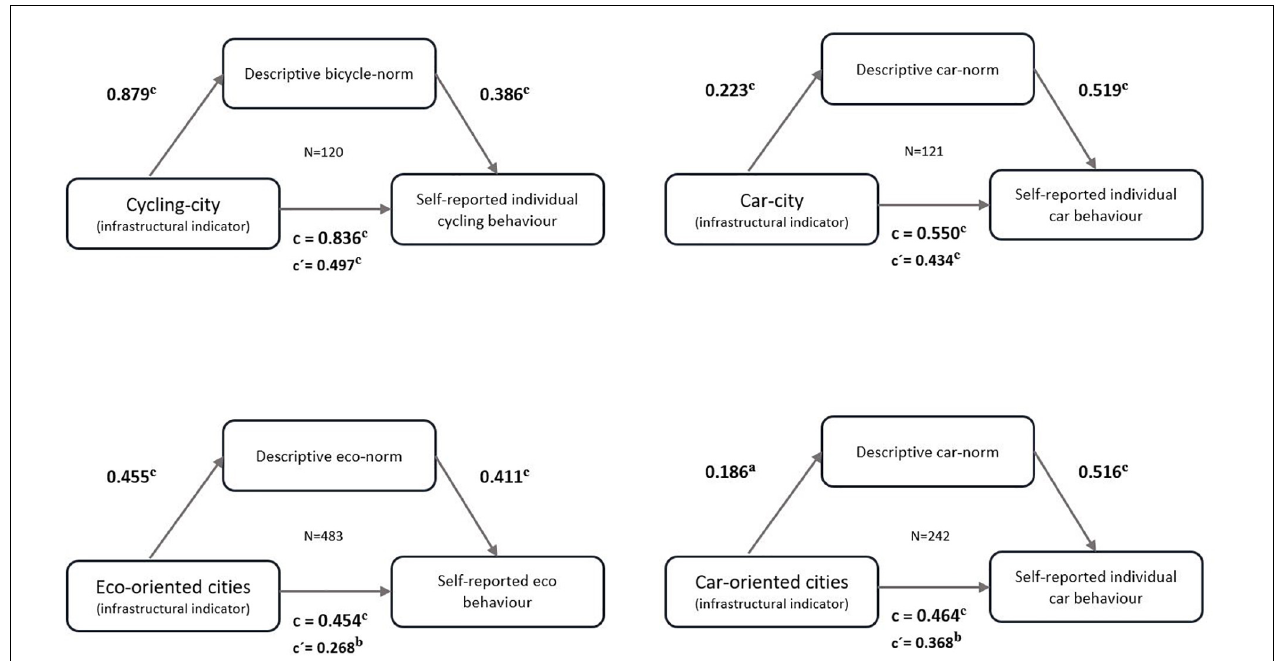
FIGURE 3 | Results of the mediation analyses using PROCESS, a < 0.05; b < 0.01; c <